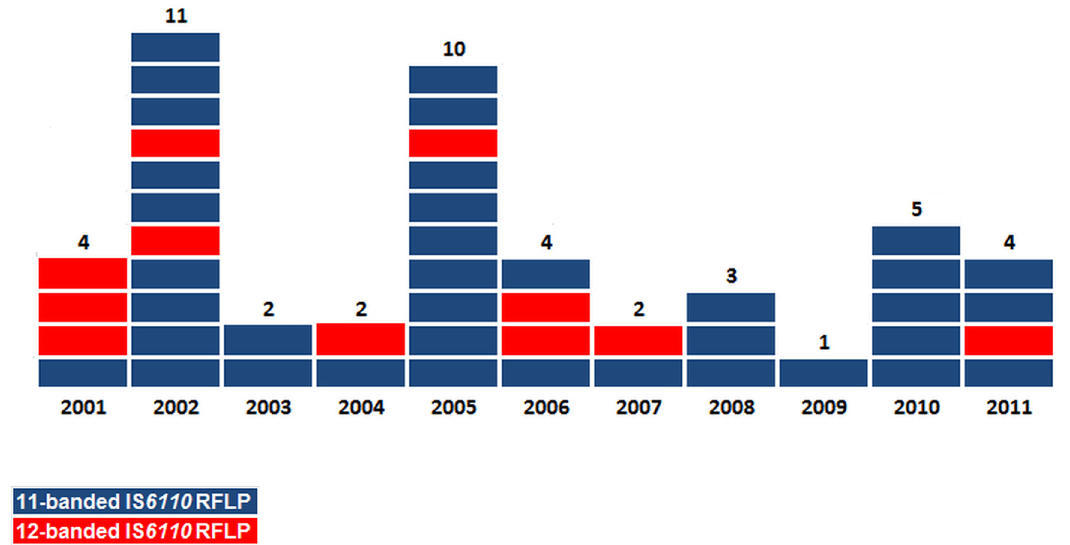
Signi fi cant P values are shown in